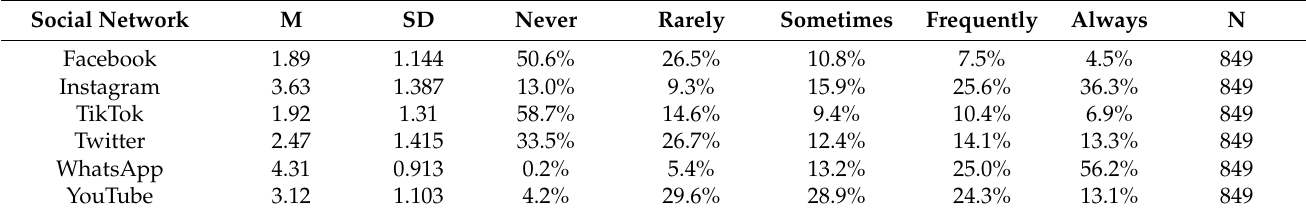
Table 2. Statistical descriptive results for the social networks’ consumption.